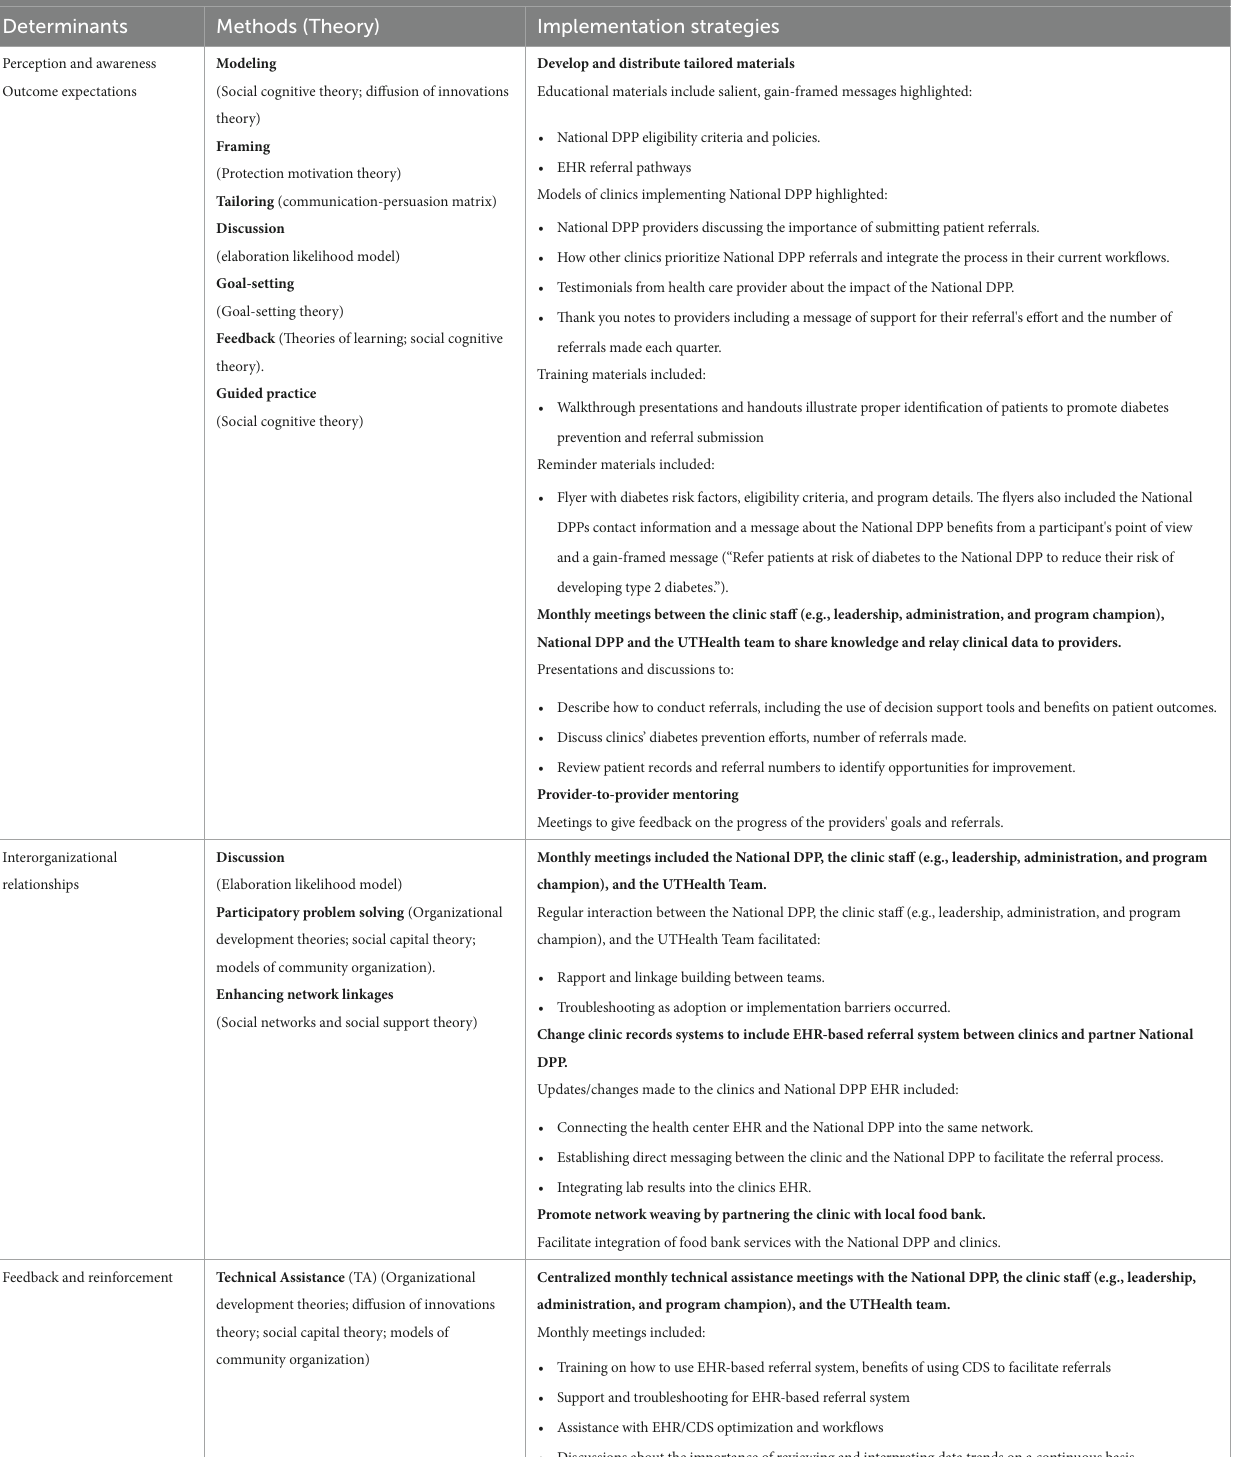
TABLE 6 Example determinants, theoretical methods, and implementation strategies. Implementation outcome:Health care provider makes referrals of patients with prediabetes to the National DPP.